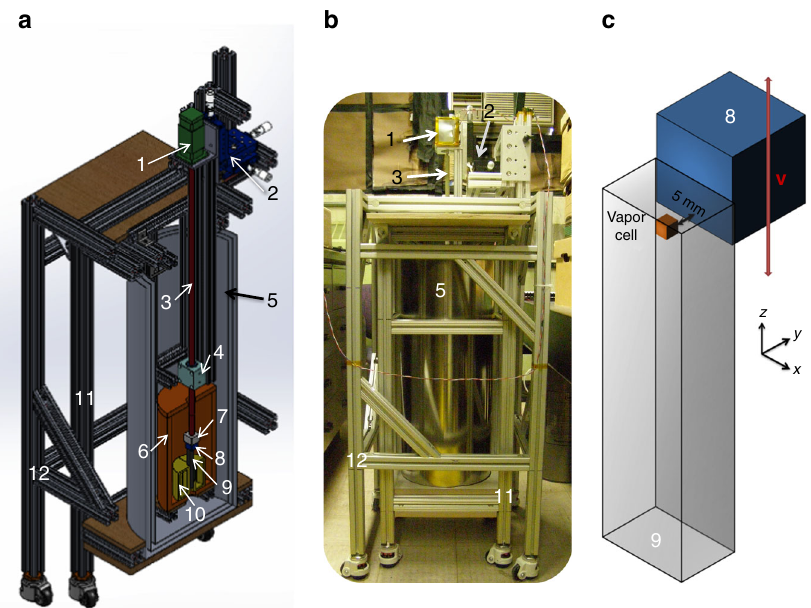
Fig. 1 The experimental setup. a A cutaway schematic diagram of the experimental setup to probe the interaction V . b A photograph of the experimental setup. c An enlarged schematic of the con fi guration of a unpolarized bismuth germanate insulator (BGO) mass and a spin-exchange relaxation-free (SERF) atomic magnetometer (scaled). In a – c , 1 is a motor enclosed by a single-layer open μ -metal box, 2 is a three-axis translation stage, 3 is a fi berglass G10 rod, 4 is a frictionless air bushing, 5 is a three-layer open μ -metal co-axial cylindrical shield, 6 is a cylindrical ferrite shield, 7 is a sample holder, 8 is a unpolarized BGO mass, 9 is a SERF atomic magnetometer, and 10 is a plastic holder for the atomic magnetometer; 11 and 12 are aluminum frames holding the motor system moving the mass and the magnetometer/shields system, respectively. The frames are decoupled so as to reduce mechanical vibrations due to the mass motion. An unpolarized BGO mass is placed next to the rubidium atomic vapor cell located inside the head of the atomic magnetometer module. The BGO mass is translated up and down in z -direction with a constant velocity